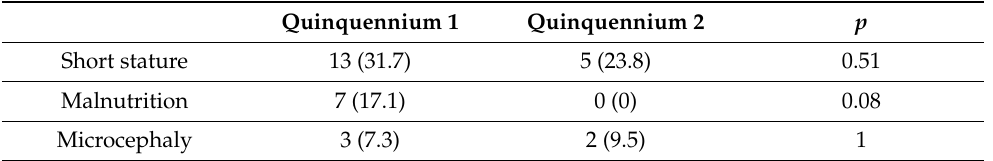
Figure 5. Evolution of standard deviation for weight, length, and head circumference at birth, hospital discharge, and 2 years (quinquennium 1: 2002–2006 vs. quinquennium 2: 2013–2017). 3.3. Changes in the 2-Year Evolution of Patients with PGF Comparing 2002–2006 vs. 2013–2017 In quinquennium 1, patients who experienced PGF were more likely to have malnutri- tion (17.1 vs. 0%, p = 0.08). It is also observed that these patients have a higher probability of height < − 2 SD, but these differences are not statistically significant. See Table 5 and Figure 6. Table 5. Somatometry at 2 years in postnatal growth faltering and appropriate for gestational age very low birth weight infants (quinquennium 1: 2002–2006 vs. quinquennium 2: 2013–2017).